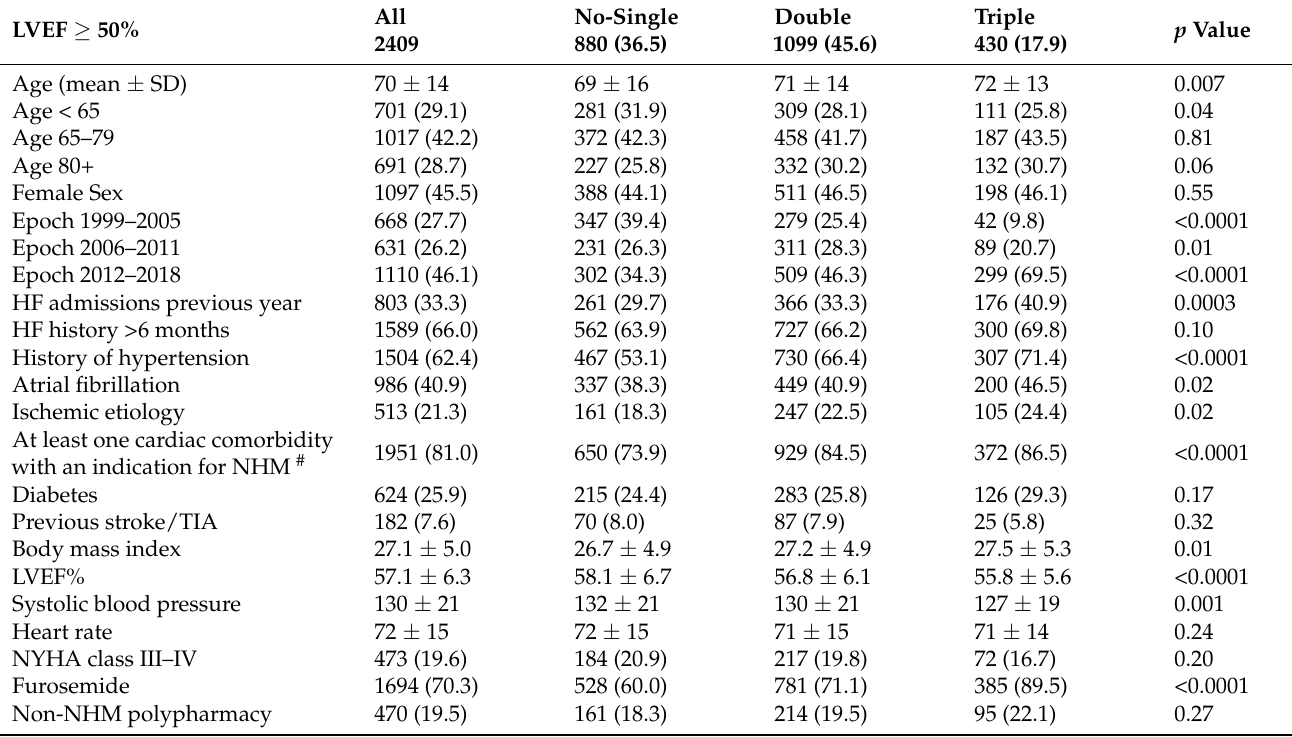
Table 2. Characteristics of HFpEF patients according to conventional